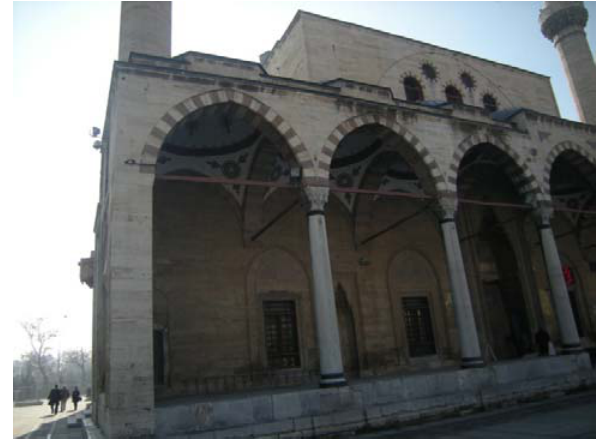
Figure 1. Front facade of the Sultan Selim